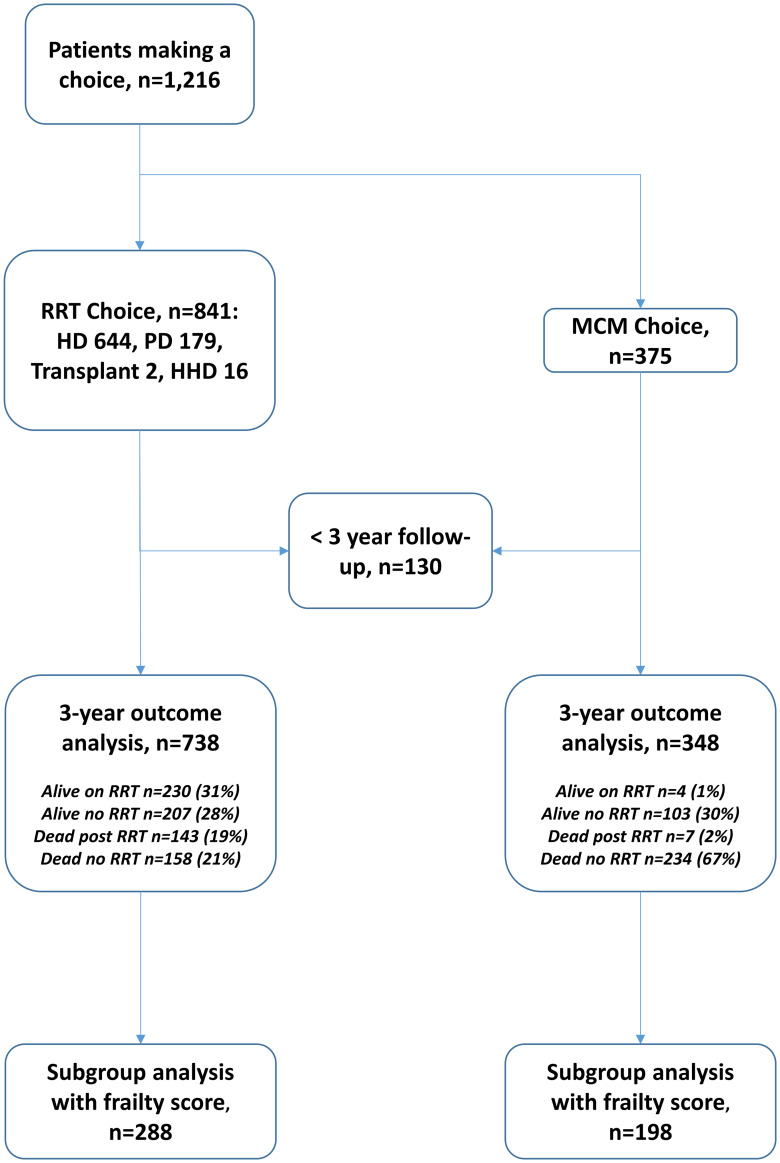
Flowchart of patients and outcomes.